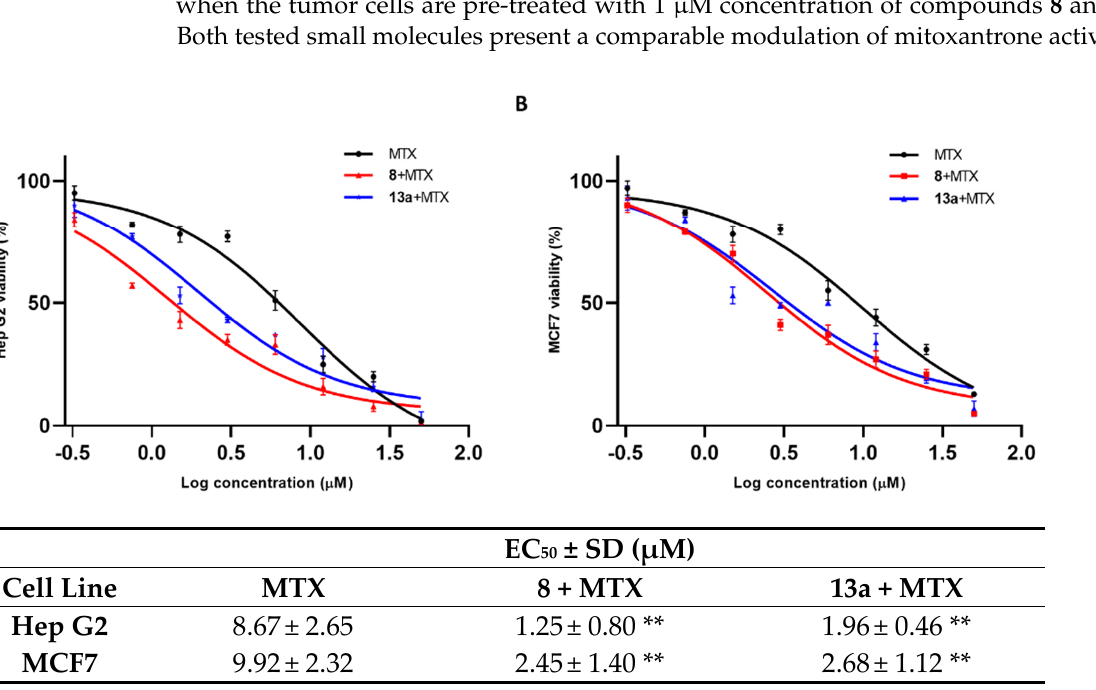
Figure 5. The EC 50 of MTX alone and in co-administration with 8 (red peak) and 13a (blue peak), at a concentration of 1 μ M in Hep G2 ( A ) and MCF 7 ( B ) cell lines. Standard deviation is expressed as error bars. Mean EC 50 values are reported in the corresponding table. ** denotes p < 0.01 vs. ctrl.